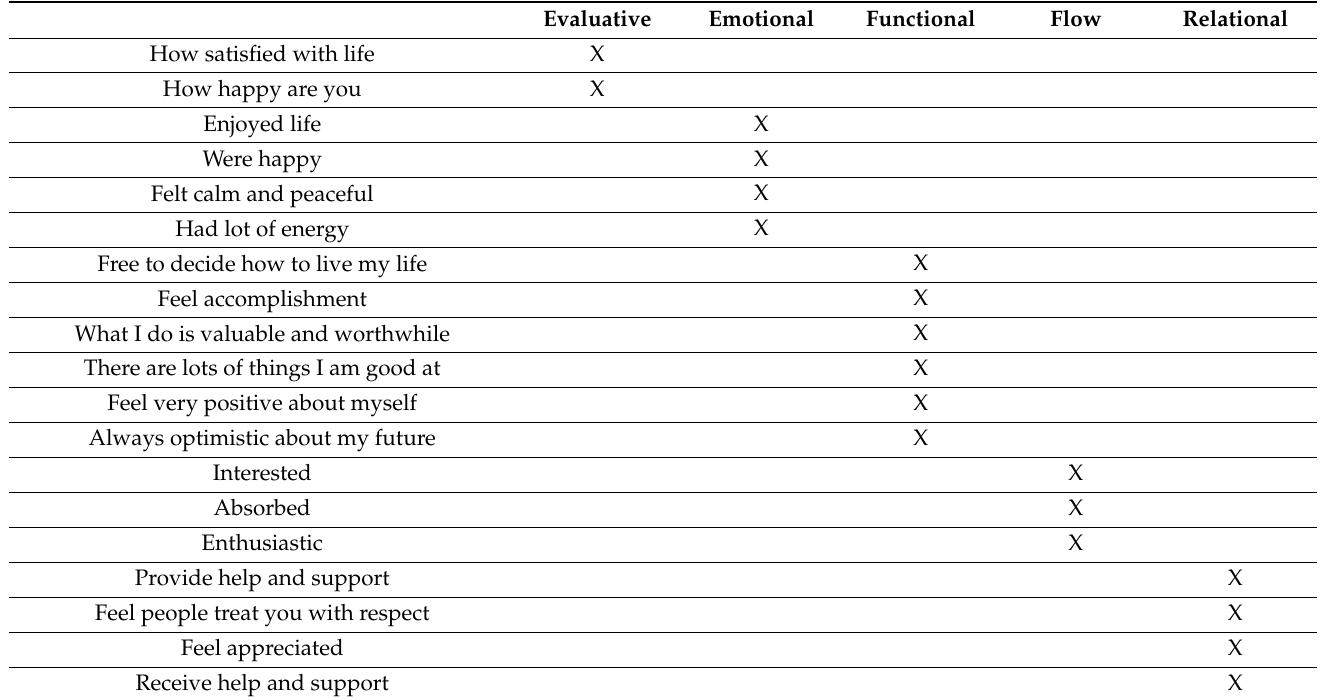
Table A1. Summary of mental wellbeing dimensions.